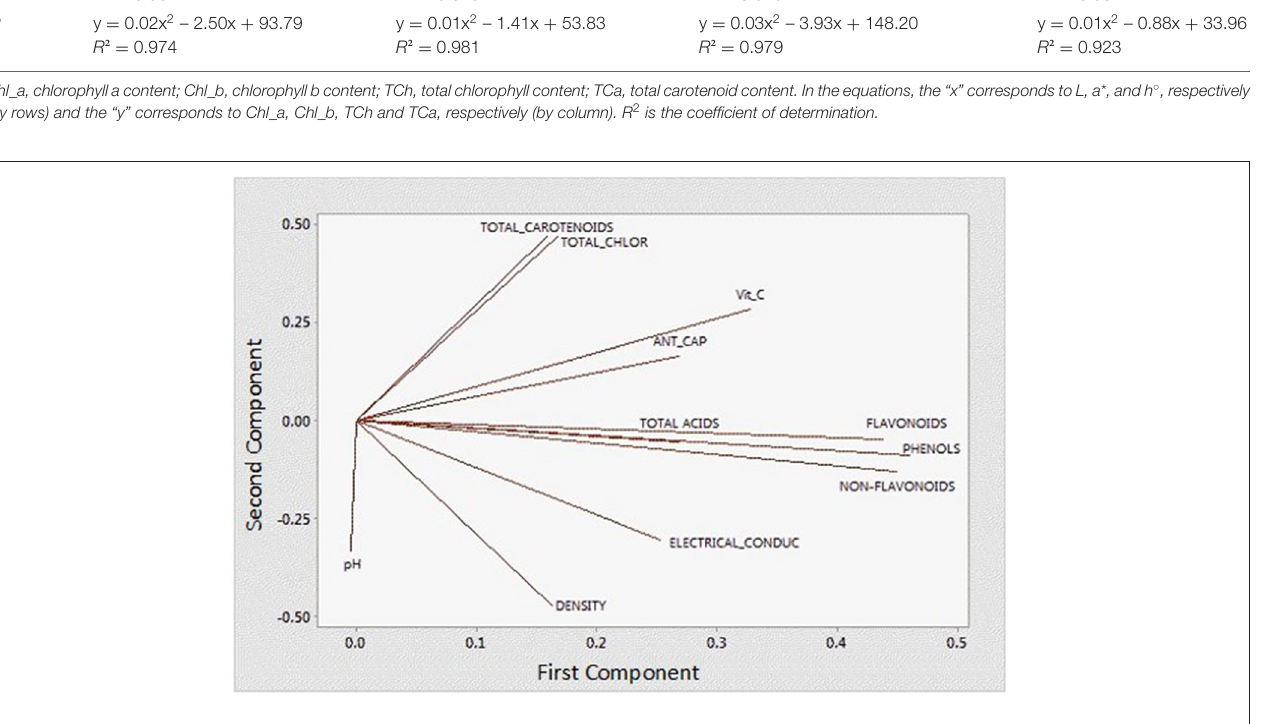
FIGURE 6 | Loading plot for the variables investigated by principal component